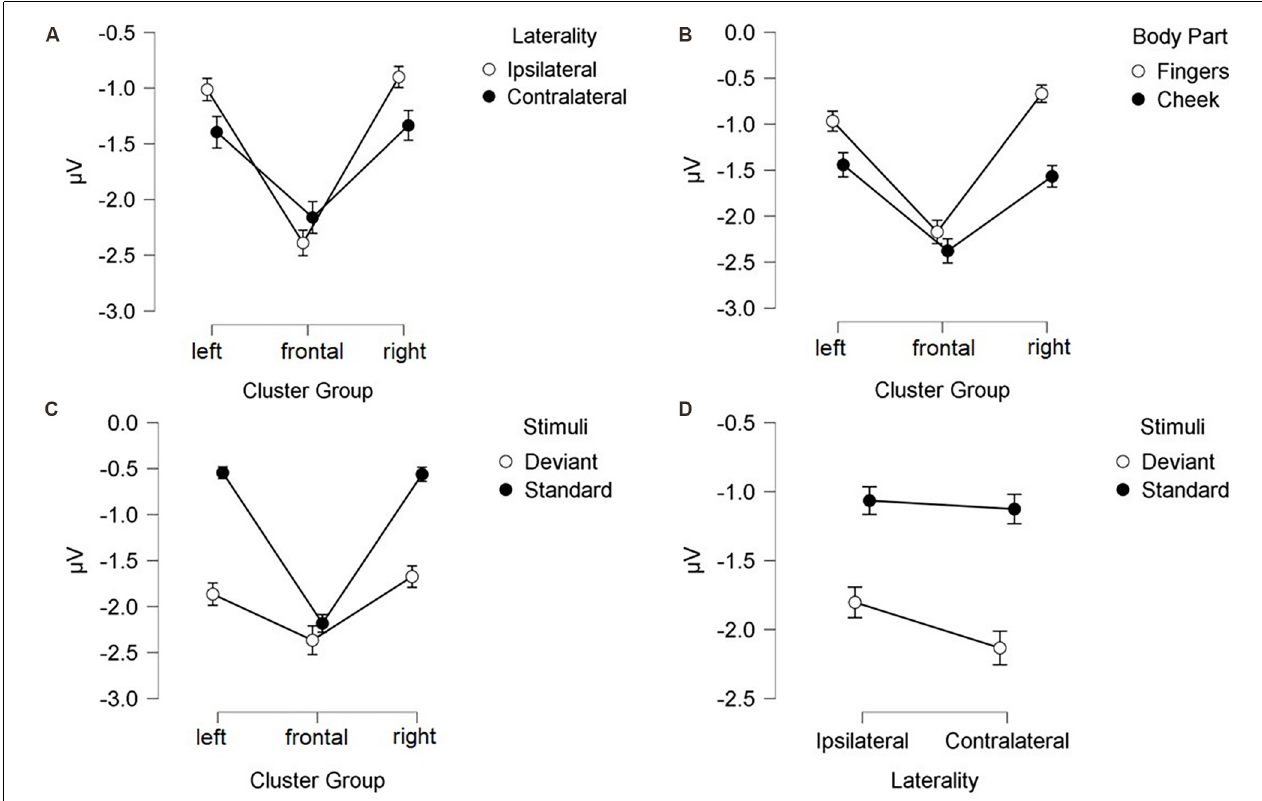
FIGURE 3 | Mean values ( µ V) of N140 amplitudes and SE. Two-way-interactions: (A) Cluster Group x Laterality, (B) Cluster Group x Body Part, (C) Cluster Group x Stimuli, and (D) Laterality x Stimuli. SE, Standard